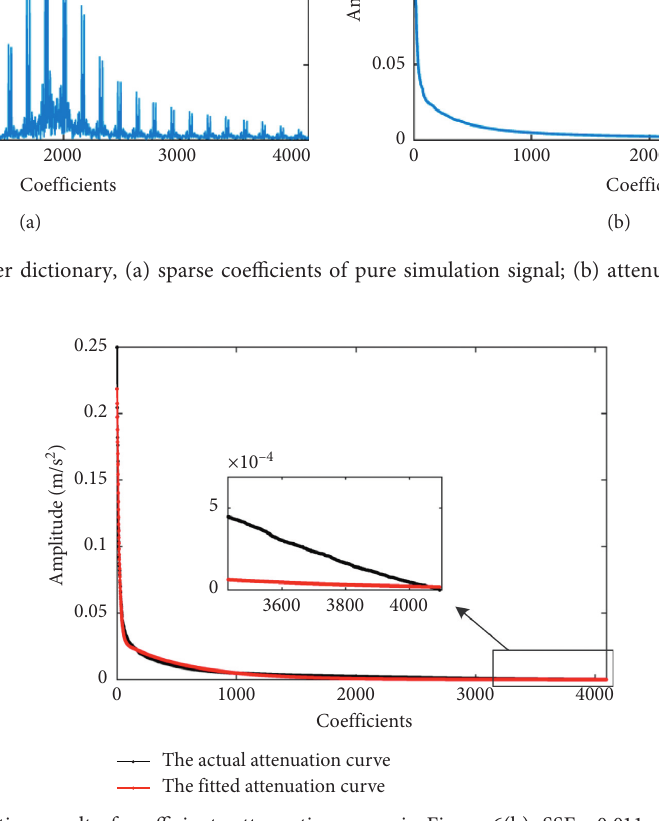
Figure 7: The fitting result of coefficients attenuation curve in Figure 6(b): SSE � 0.011; R -square � 0.984.